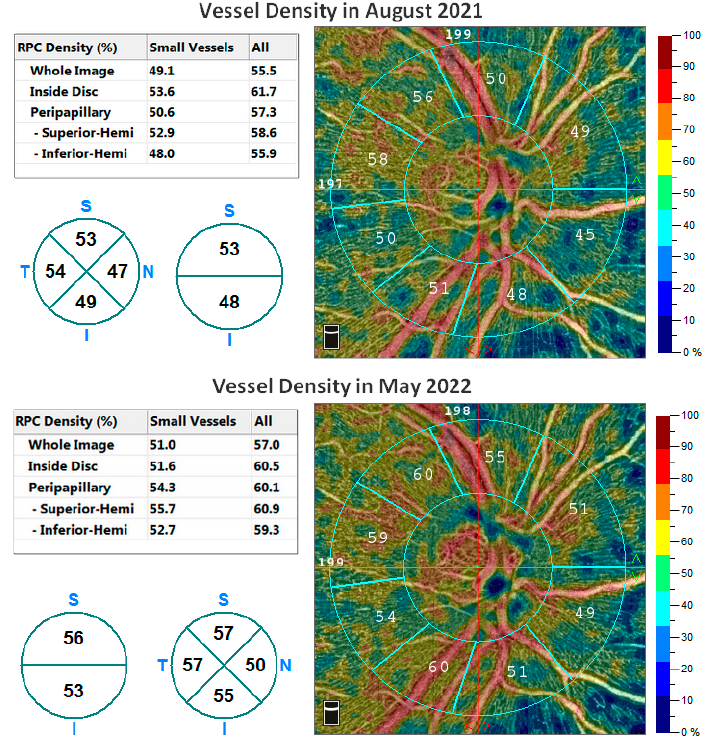
Figure 1. Comparison of the density of blood vessels in the patient’s right eye from October 2021 (upper part) and May 2022 (lower part).